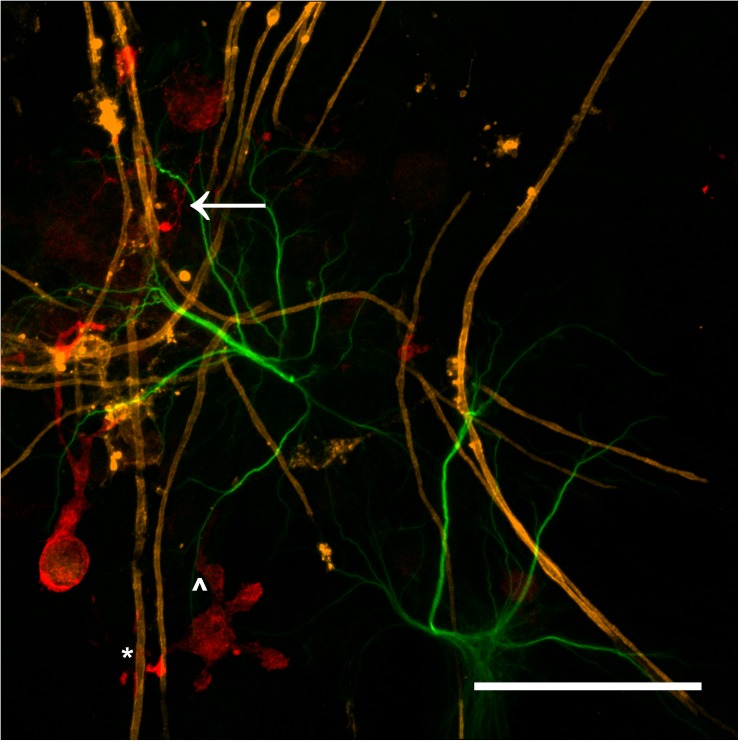
Maximum intensity projection of a 100x magnification tile scan from a concurrent co-culture demonstrating the potential interaction between microglia (red), myelin (orange), and astrocytes (green). Very fine ramified microglial processes can be seen in the upper left (arrow). Microglia can be observed in close apposition with myelin (∗) and astrocytes (∧) (Scale bar = 50 μm).